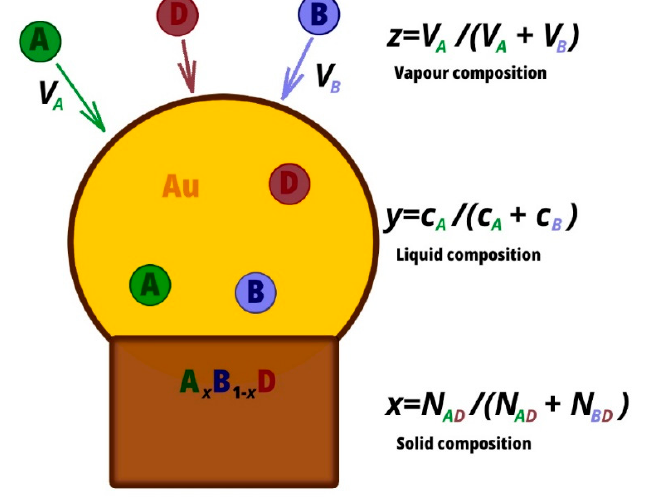
Figure 1. Schematic illustration of the system.